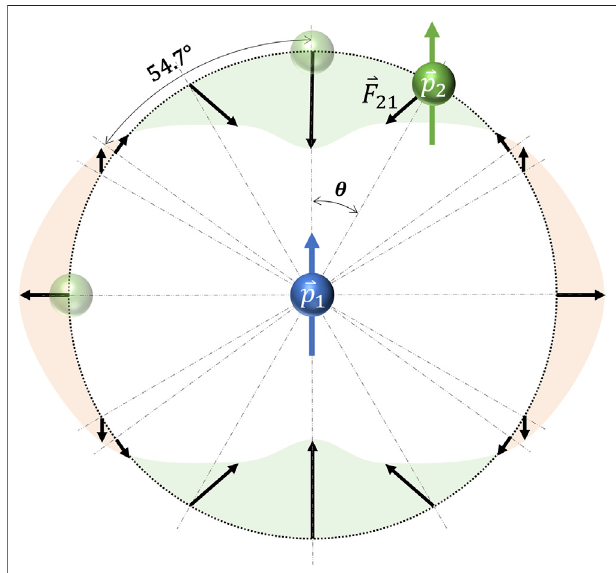
FIGURE 1 | Spatial position of parallel isotropic dipole and variation of force with